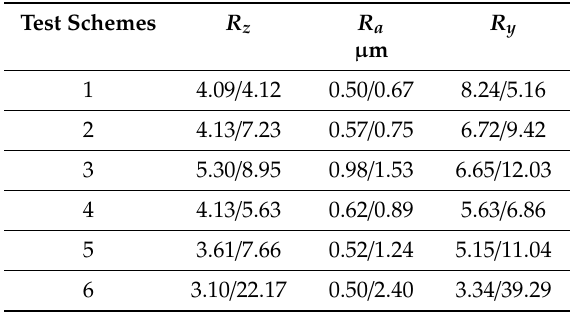
Table 3. Roughness of the initial (in the numerator) and damaged (in the denominator) surface of specimens from steel 20 under di ff erent test